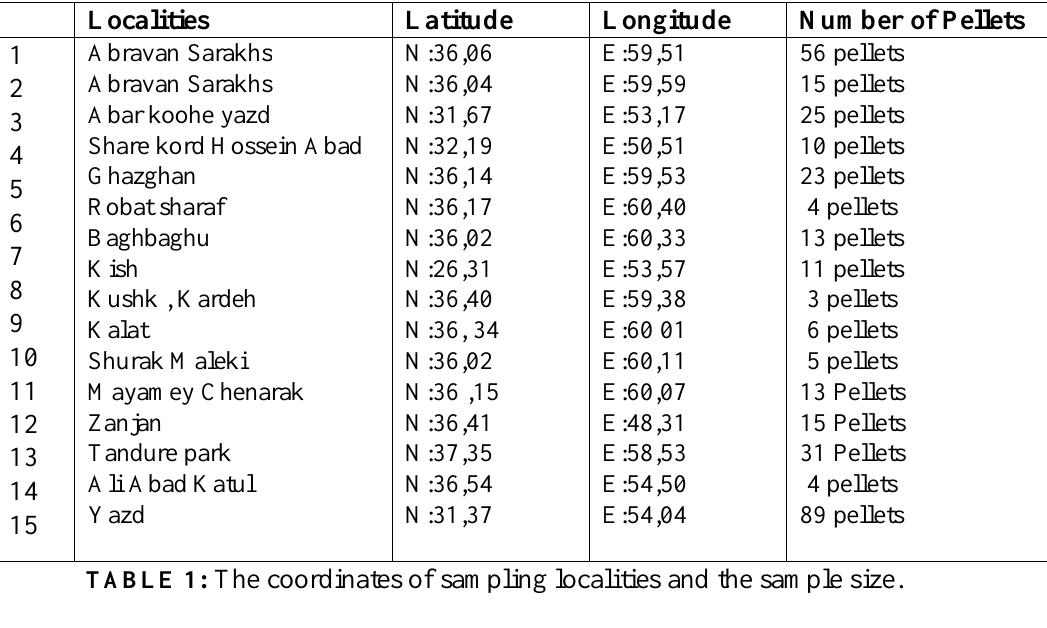
Localities Latitude Longitude Number of